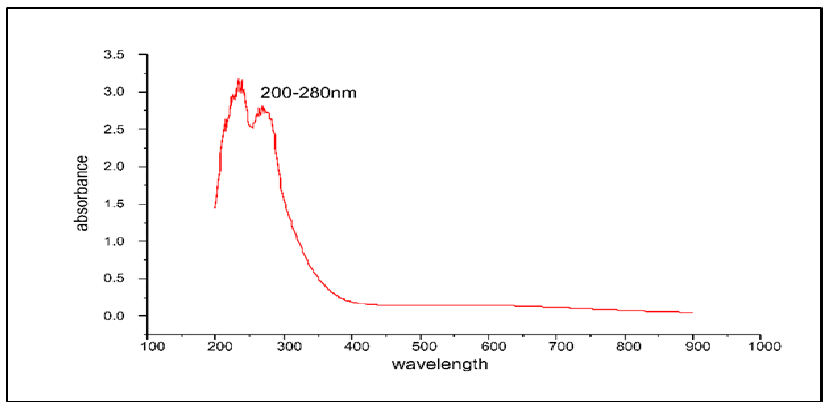
Figure 5. The UV-Visible spectrum of the ZnO-NPs synthesized by Aloe barbadensis leaf extract at a maximum wavelength of 200–280